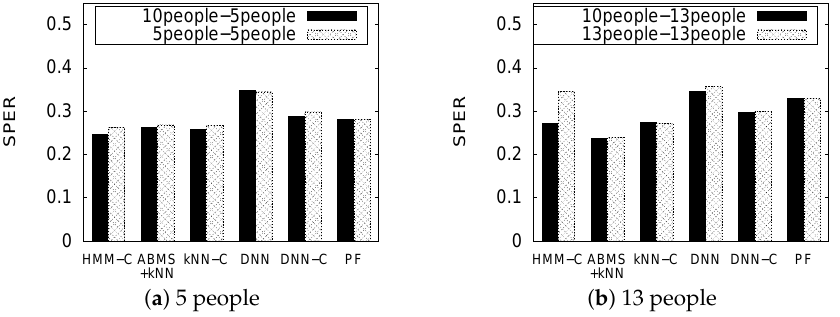
Figure 16. Results of indoor positioning in a dynamic